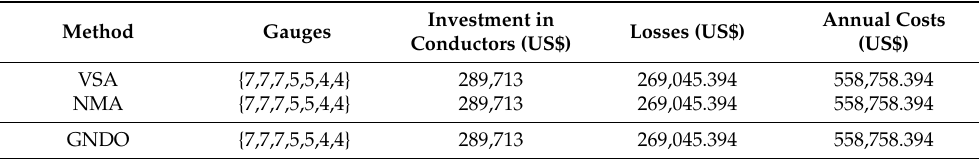
Table 11. Solutions obtained by different optimization